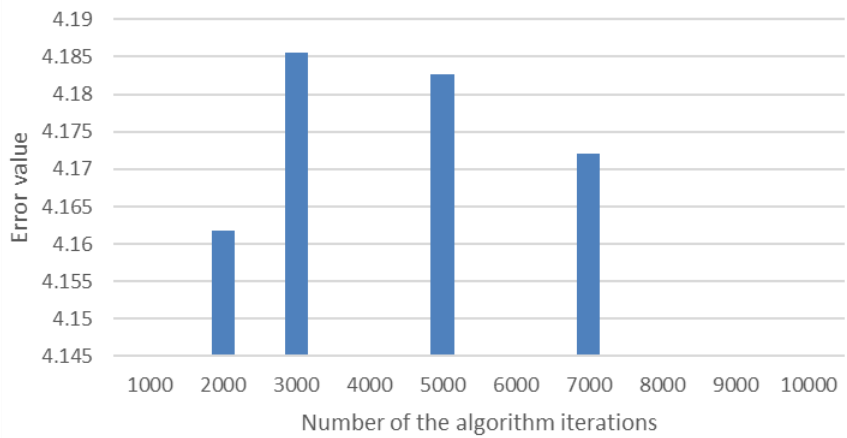
Figure 5. Dependence of the approximation accuracy on the number of iterations of the proposed evolutional method.